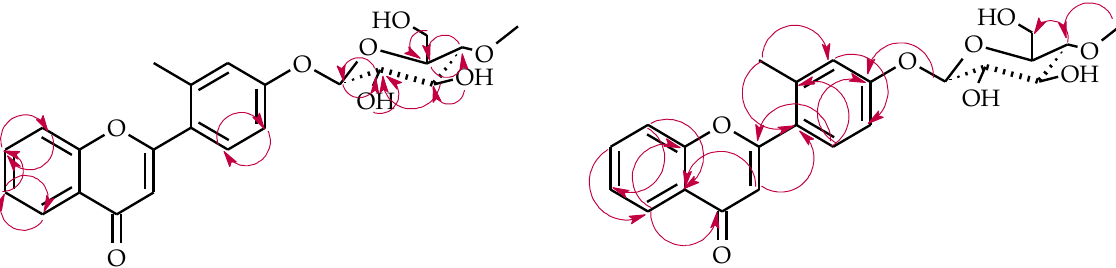
Table 4. Cont. Carbon Scheme 9. Microbial transformation of 2′ -methylflavone ( 5 ) in the I. fumosorosea KCH J2 culture. The products 5a – 5c were analyzed by 1 H-NMR, 13 C-NMR, and correlations spectros- copy that allowed for the establishment of their chemical structures (Tables 3 and 4, Schemes 10 – 12 showing key COSY and HMBC correlations). In all three products oc- curred 4 ″ - O -methylglycosylations that were confirmed by characteristic signals in the 13 C NMR and 1 H NMR spectra, analogically to the products 4a – 4d (Supplementary Materials: Figures S125, S122, S141, S138, S158, and S155). The presence of the three-proton singlet of the methyl group at C-2 ′ (δ = 2.37 ppm in 5a , δ = 2.49 ppm in 5b, and δ = 2.44 ppm in 5c ) in the 1 H-NMR spectra of these products showed that the methyl moiety remained in all three products. In product 5a , the three-proton singlet of the methyl group at C-2 ′ was shifted from δ = 2.51 ppm (in 5 ) to δ = 2.37 ppm in 5a , indicating substitution at adjacent C-3 ′ position (Supplementary Materials: Figure S122). Glycosylation occurring at C-3 ′ was confirmed in the HMBC experiment by coupling of the proton at the anomeric carbon atom (δ = 5.00 ppm) with the C-3 ′ signal at δ = 157.2 ppm, which was shifted from δ = 132.1 ppm, indi- cating an electronegative atom attachment (Supplementary Materials: Figure S134). Ad- ditionally, in the 13 C NMR spectrum the signals from C-2 ′ and C-4 ′ became shifted from δ = 137.7 ppm to δ = 127.4 ppm and δ = 131.6 ppm to δ = 118.2 ppm, respectively (Supple- mentary Materials: Figure S124). In the HMBC experiment the methyl moiety at C-2 ′ (δ = 2.37 ppm) was coupled with shifted C-3 ′ signal δ = 157.2 ppm same as doublet signal from Int. J. Mol. Sci. 2021 , 22 , x FOR PEER REVIEW 11 of 20 proton at C-1 ″ also confirming that glycosylation occurred at C-3 ′ (Supplementary Mate- rials: Figure S134) (Scheme 10). 3 ′ , and C-5 ′ became shifted, and the proton at C-4 ′ disappeared (Supplementary Materials: OHOOH Figure S137). The three-proton singlet of the methyl group at C-2 ′ was only slightly shifted from δ = 2.51 ppm (in the substrate 5 ) to δ = 2.49 ppm in 5a , indicating substitution at further C-4 ′ position (Supplementary Materials: Figure S138). Glycosylation at C-4 ′ was OH confirmed in the HMBC experiment by coupling between the proton at the anomeric car- bon atom (δ = 5.06 ppm) and the C -4 ′ signal (δ = 160.4 ppm), which was shifted from δ = 131.6 ppm (Supplementary Materials: Figure S151). Additionally, in the HMBC experi- ment, the methyl moiety at C-2 ′ (δ = 2.49 ppm) was coupled with shifted carbons signals: C-3 ′ ( δ = 119.9 ppm), C-2 ′ ( δ = 139.6 ppm), and C-1 ′ ( δ = 127.4 ppm) (Supplementary Mate- rials: Figure S151). The signal from proton at C-6 ′ (δ = 7.59 ppm) was also coupled with C- 4 ′ (δ = 160.4 p pm) and C-2 ′ ( δ = 139.6 ppm) in the HMBC experiment (Supplementary Scheme 10. Key COSY (on the left) and HMBC (on the right) correlations for the structure elucidation of product 5a . Materials: Figure S149) (Scheme 11). The 1 H NMR spectrum of product 5b indicates that another product of glycosylation occurred. The protons from the A ring remained intact, but protons from B ring at C-6 ′ , C-